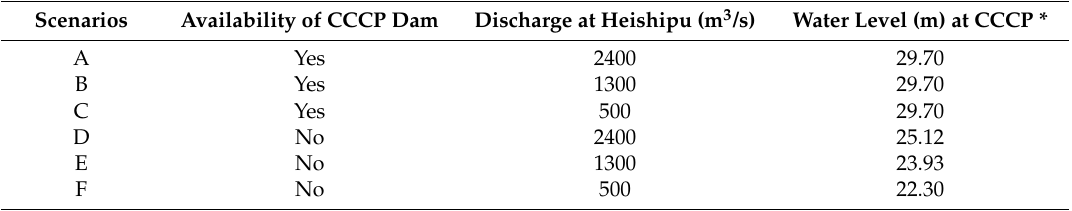
Table 1. Different Scenarios in flow and water level